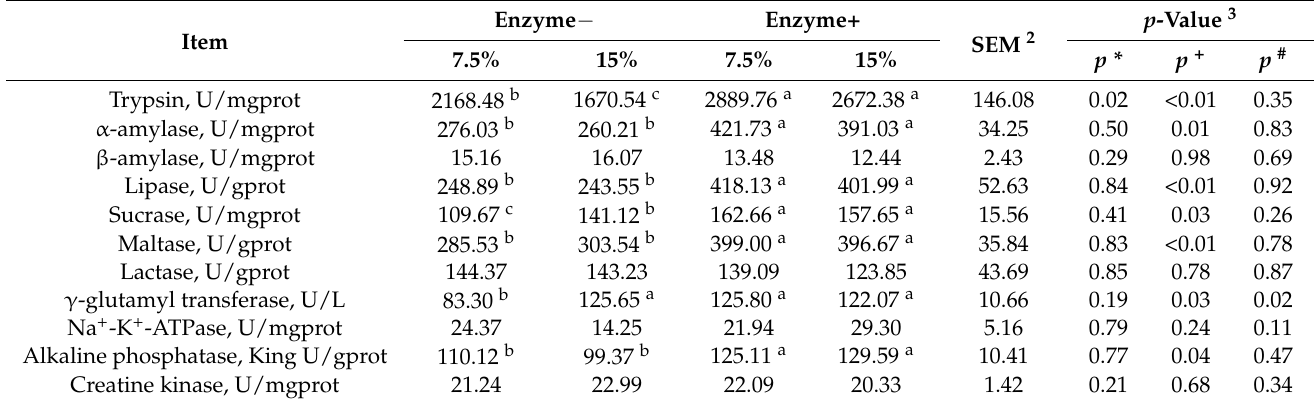
Table 6. Effects of different moisture contents (adding 7.5 vs. 15% water) and enzyme additions (adding 4 kg/t α -amylase or not) to extruded corn on the digestive and absorptive enzyme activities